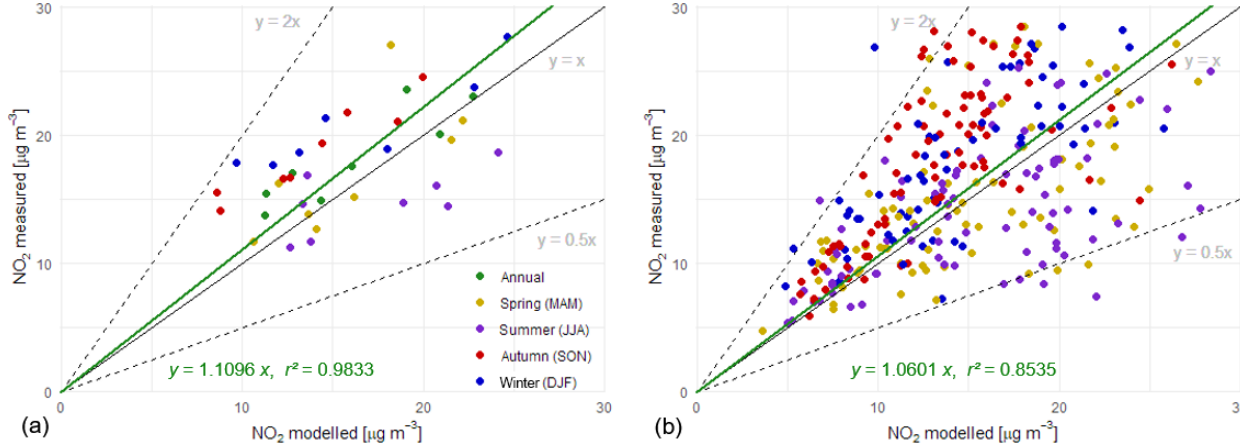
Figure 6. Modelled versus measured NO 2 concentrations at all available measurement stations in the Gda´nsk–Gdynia research domain. Panel (a) shows annual station averages, with each dot indicating one station, while panel (b) shows daily averages, with each dot indicating an average of all stations. For panels (a) and (b) the colours display